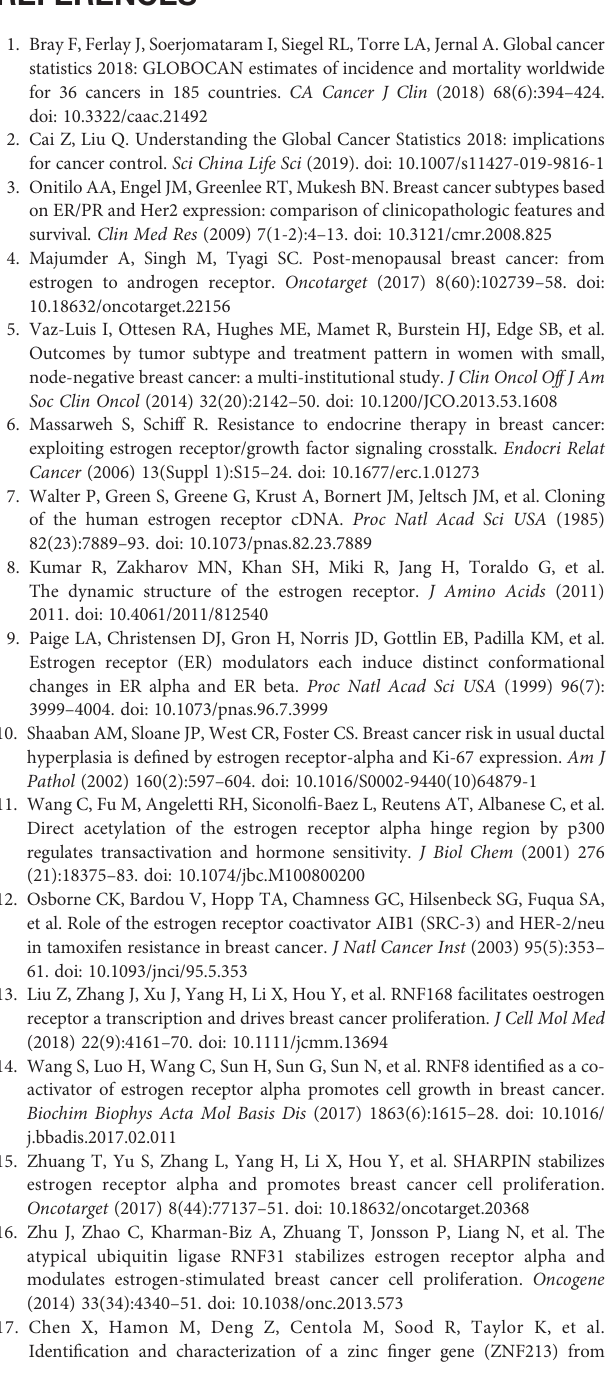
Supplementary Figure 2 | ZNF213 is required for cell migration in breast cancer cells. (A – D) Wound healing assay of MCF-7and T47D cells transfected with the